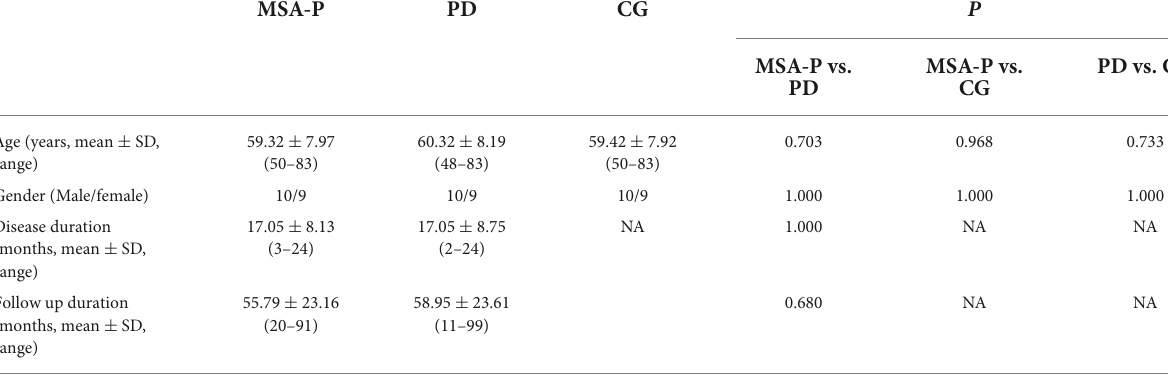
TABLE 1 The demographic characteristic of multiple system atrophy-parkinsonian subtype, Parkinson’s disease and control group.